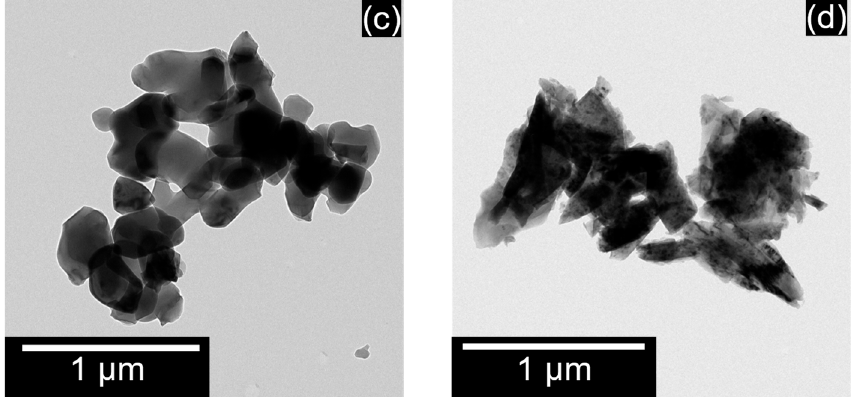
Figure 3. SEM of ( a ) tungsten carbide, TEM of ( b ) carbon nanofiber, ( c ) alumina, ( d ) silicon particles.